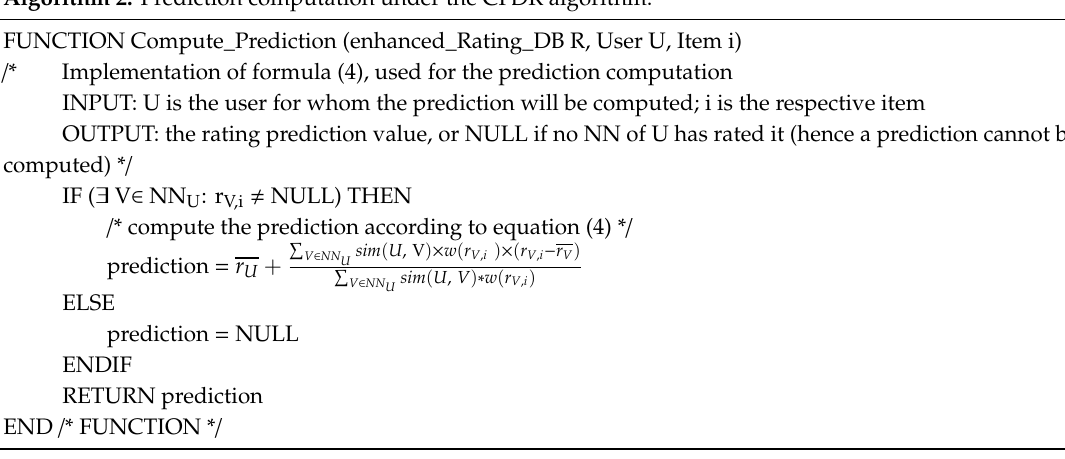
Algorithm 2. Prediction computation under the CFDR